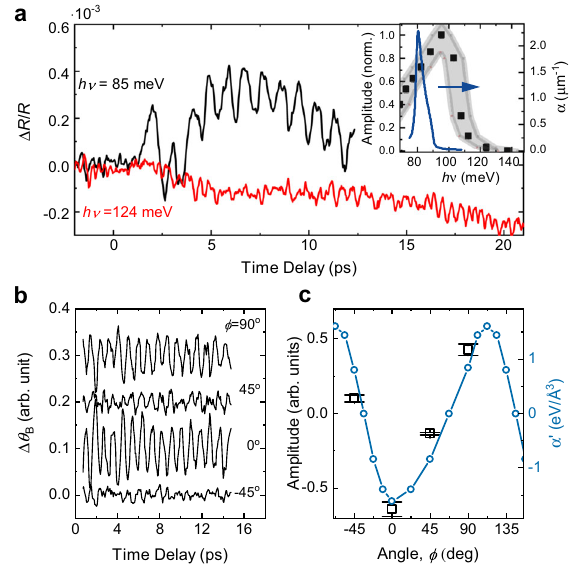
Fig. 3 Light-induced excitation and dynamics of oxygen octahedra rotations. a Time-resolved re fl ectivity changes of the probe pulse at the central energy of 1.5 eV after mid-IR excitation at photon energies of 83 and 124 meV. Inset: the amplitude of the coherent phonon oscillations at 1.1 THz, as extracted from fi tting an exponentially damped sine function to the transient re fl ectivity changes for different pump photon energies at constant incident fl uence. The thick blue solid line indicates the linear absorption due to the E u phonon mode, data taken from refs. 14,50 . The spectral full-width at half-maximum of the excitation pulses is indicated by the shaded band. b Time-resolved measurements of the transient polarization rotation of the probe pulse after excitation with the pump pulses having a polarization of ϕ degrees with respect to the pseudocubic [100] axis at a pump energy of 89 meV. c Amplitude of the observed E g mode excitation (square markers) as extracted by fi tting sine functions to the data in b and calculated coupling of the excited phonons to the E g mode (blue circles) vs pump polarization angle ϕ . The errorbars account only for the uncertainty of the fi